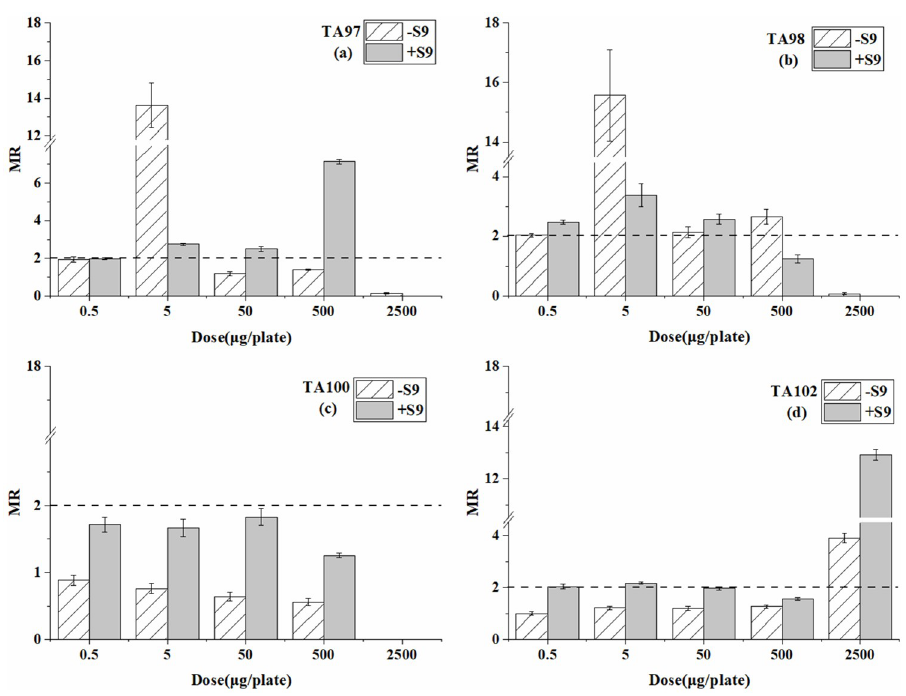
Fig 2. Mutagenesis of BP-8 to four strains in the presence and absence of S9 liver extract; (a) TA97 strain; (b) TA98 strain; (c) TA100 strain; (d) TA102 strain. The mutation ratio (MR) is the average ratio ( ± SE) from three parallel